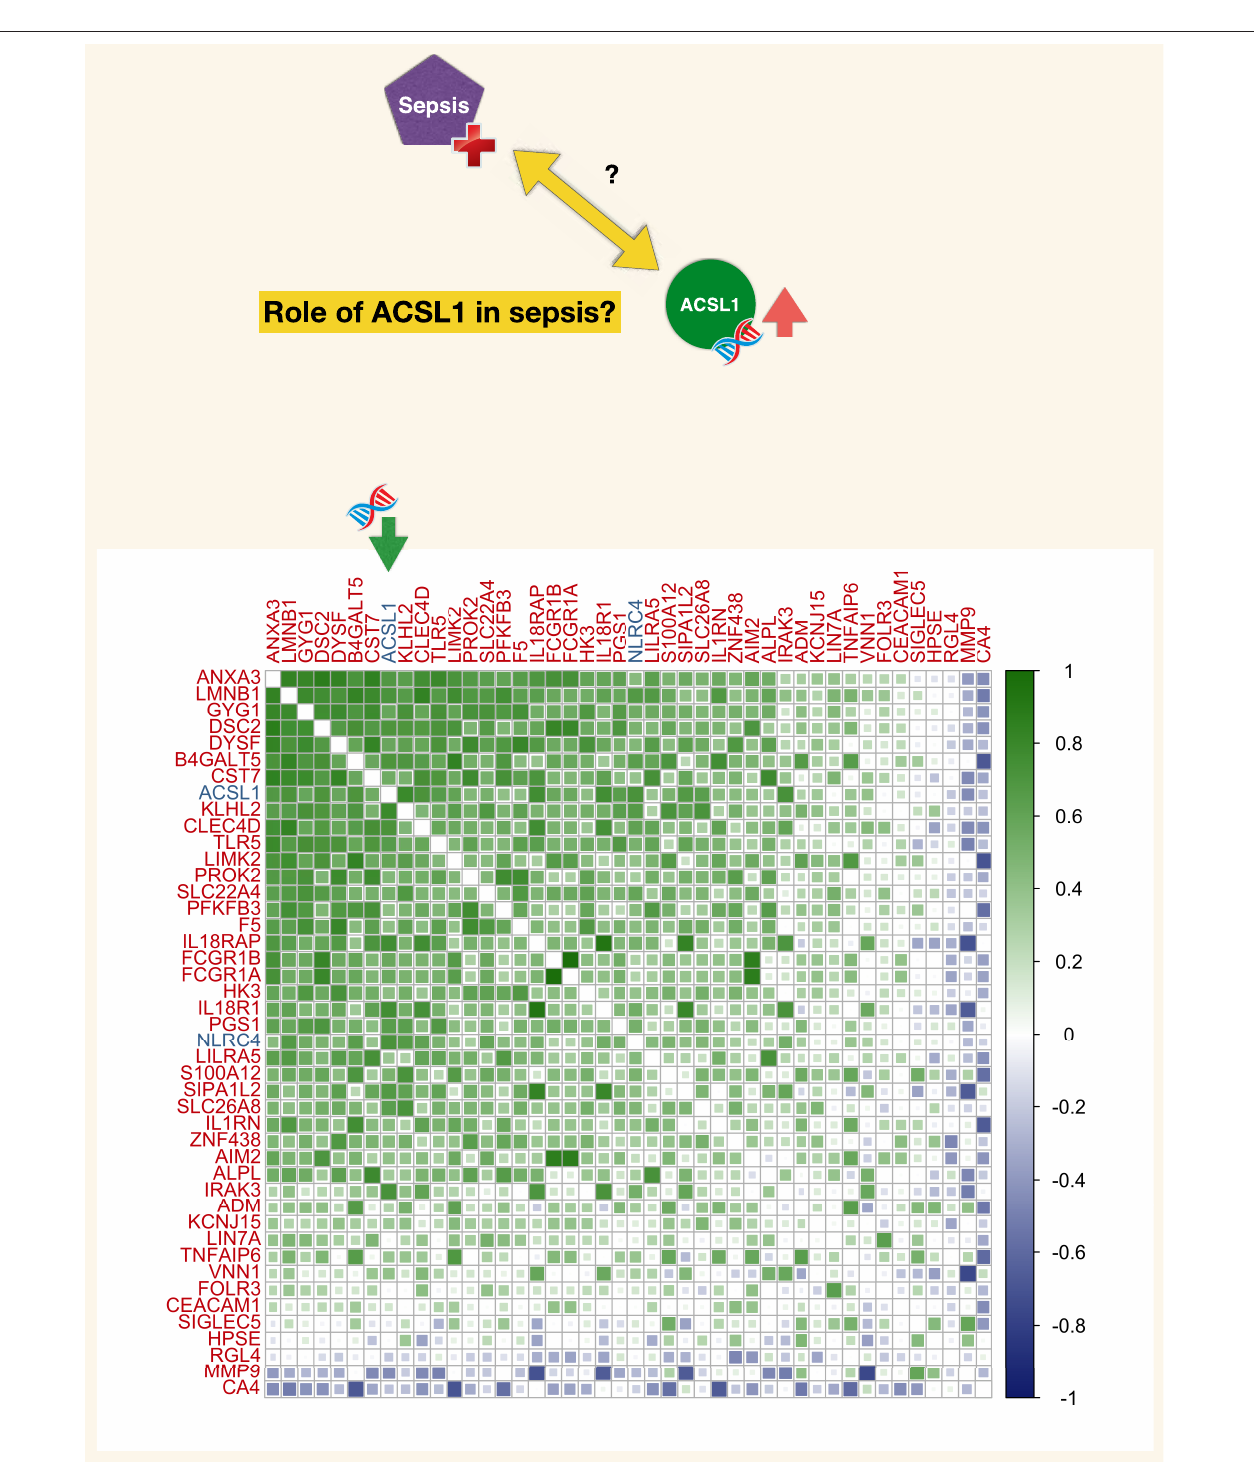
FIGURE 5 | Correlation matrix for a set of genes constituting a blood transcriptional module associated functionally with neutrophil-driven inflammation (M13.12). The blood transcriptional module is part of a recently described repertoire constructed on the basis of co-expression across a 16 different immune/pathological states (described in the text). The list of genes constituting this module (M13.12) comprised ACSL1. The matrix represents degree of correlation calculated for each gene pair for the septic plasma neutrophil exposure dataset.